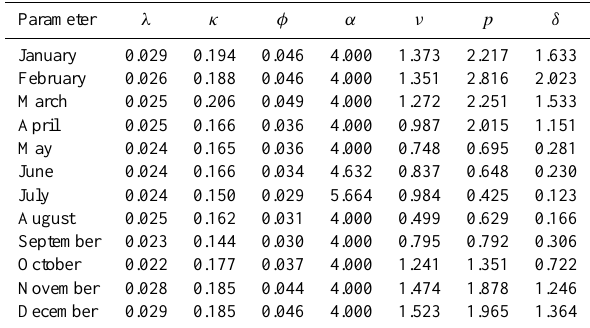
Table A3. Parameter set used for the MBLG